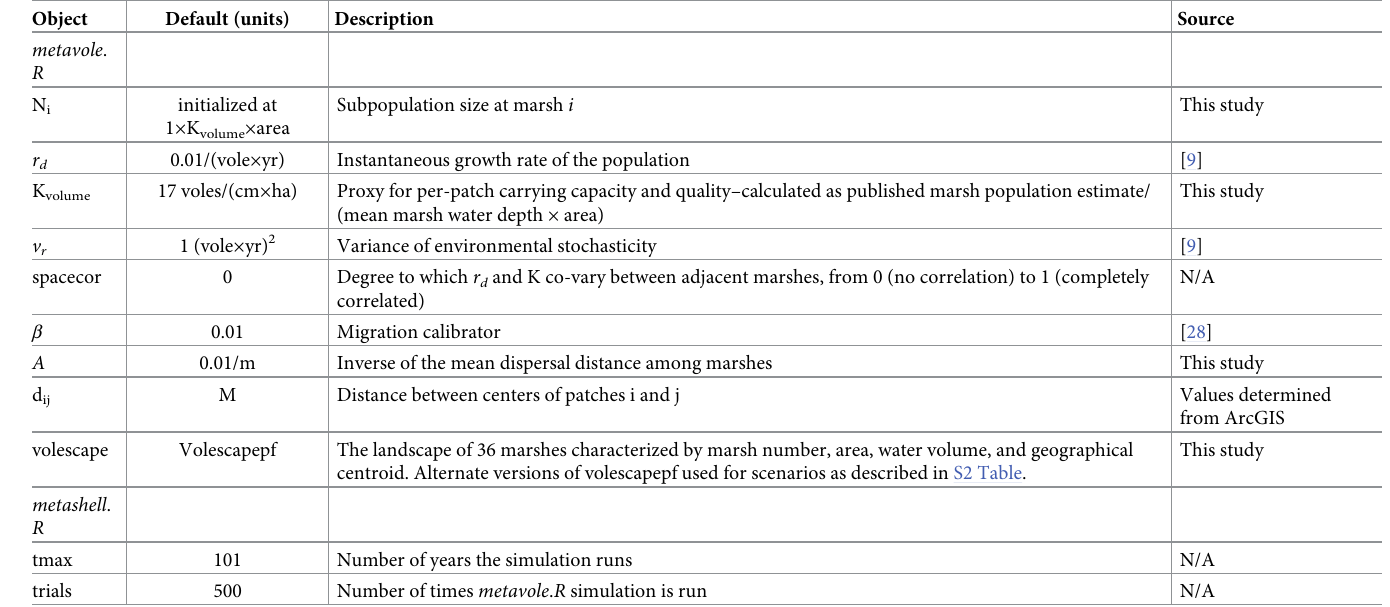
Table 1. Parameter values in metavole . R . Objects used in metavole . R , a spatially structured metapopulation model of Amargosa voles. N/A indicates a data source is not applicable for a given